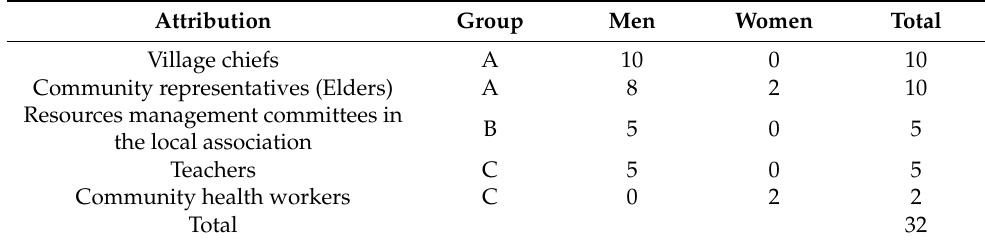
Table 3. Distribution of participants within the